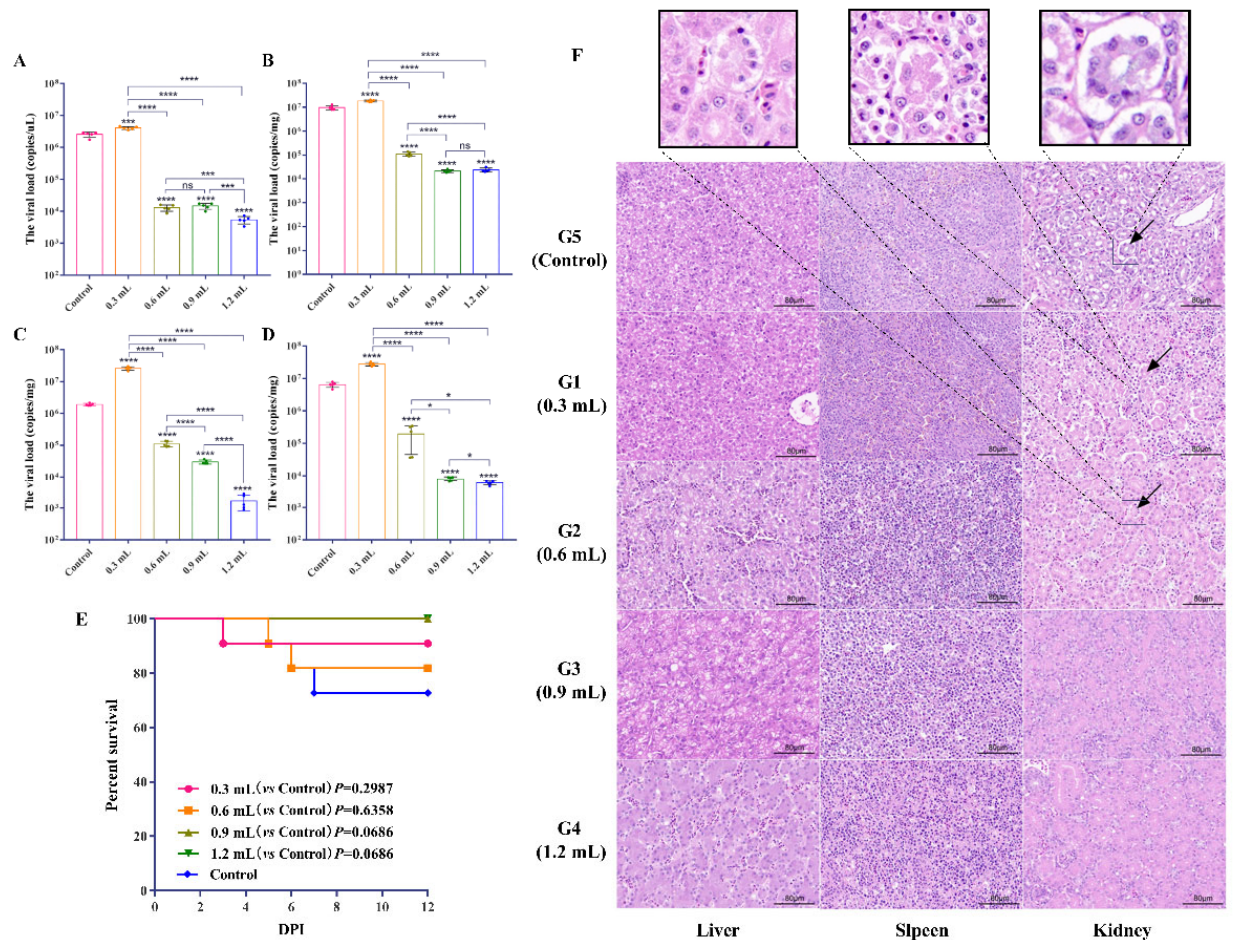
Figure 3. Estimation of the preventive effect of different doses of the anti-GAstV IgY. The mRNA levels of GAstV-AHQJ18 in cloacal swabs ( A ), liver ( B ), spleen ( C ), and kidney ( D ). The survival rates of G1–G5 were monitored daily for 12 days ( E ). Survival data were analyzed by log-rank (Mantel–Cox) test. Pathological changes in the infected goslings in G1–G5 ( F ). Necrosis and inflammatory infiltration in liver (H&E) were observed in G1, G2, and G5. Kidney (H&E) in groups G1, G2, and G5, renal tubular epithelial cells severe degeneration and necrosis, and the brush border structure of the proximal convoluted tubule was destroyed (black arrow). Kidney (H&E) in groups G3 and G4, brush border structure of the proximal convoluted tubule intact. In all panels with p values are expressed as mean ± SD, n = 5. * p < 0.05; *** p < 0.001, **** p < 0.0001, ns p > 0.05. Scale bar = 80 μ m.